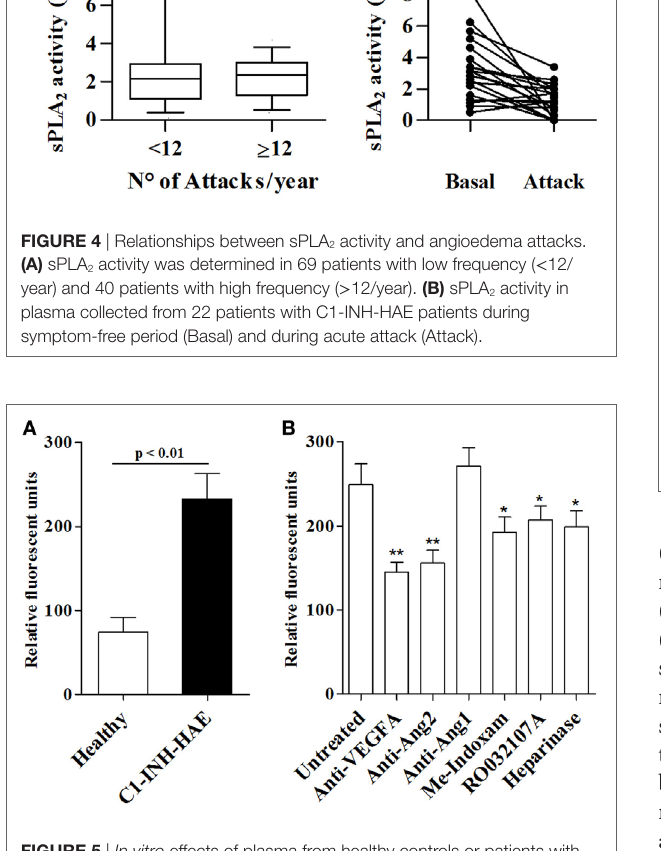
FigUre 5 | In vitro effects of plasma from healthy controls or patients with C1-INH-HAE on vascular permeability. (a) Bovine aortic endothelial cells (BAEC) were incubated (18 h, 37°C) with plasma from healthy controls or from symptom-free patients with C1-INH-HAE. The in vitro vascular permeability was assessed as indicated in Section “Materials and Methods.” (B) Plasma of patients with C1-INH-HAE was incubated (20 min, 37°C) with anti-VEGF-A (1 µg/ml), anti-Ang2 (1 µg/ml), anti-Ang1 (1 µg/ml), Me-Indoxam (100 nM), RO032107A (100 nM), or control medium. BAEC were then pre-incubated (30 min, 37°C) with heparinase (0.4 U/ml) or control medium and stimulated (18 h, 37°C) with plasma of C1-INH-HAE patients alone or with the combination of C1-INH-HAE plasma with inhibitors and then we evaluated vascular permeability. Data are shown in relative fluorescence units. * p Value ≤ 0.05 and ** p value ≤ 0.01 vs untreated plasma.